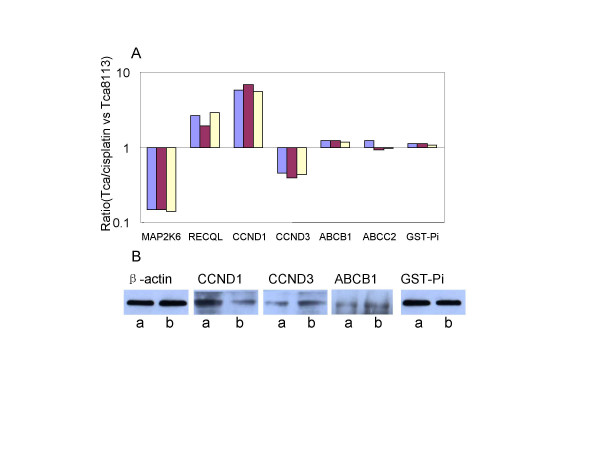
Validation of genechip results by Real-time PCR and Western blotting. A: Using Real-time PCR, we validated the expression of MAP2K6, RECQL, CCND1, CCND3, ABCB1, ABCC2 and GST-Pi transcripts in both cell lines and calculated the relative fold changes by normalizing against GAPDH expression. Ratios of transcripts in Tca/cisplatin cells and Tca8113 cells generally showed the same expression differences as microarray analysis. Each column represents the results of an independent experiment (repeated three times). B: Using Western blotting, we further validated the expression of CCND1, CCND3, ABCB1 and GST-Pi proteins in both cell lines, using β-actin as a loading control. The results also show alterations similar to those found using the genechip. Each figure represents three independent experiments. (a: Tca/cisplatin cells, b:Tca8113 cells).